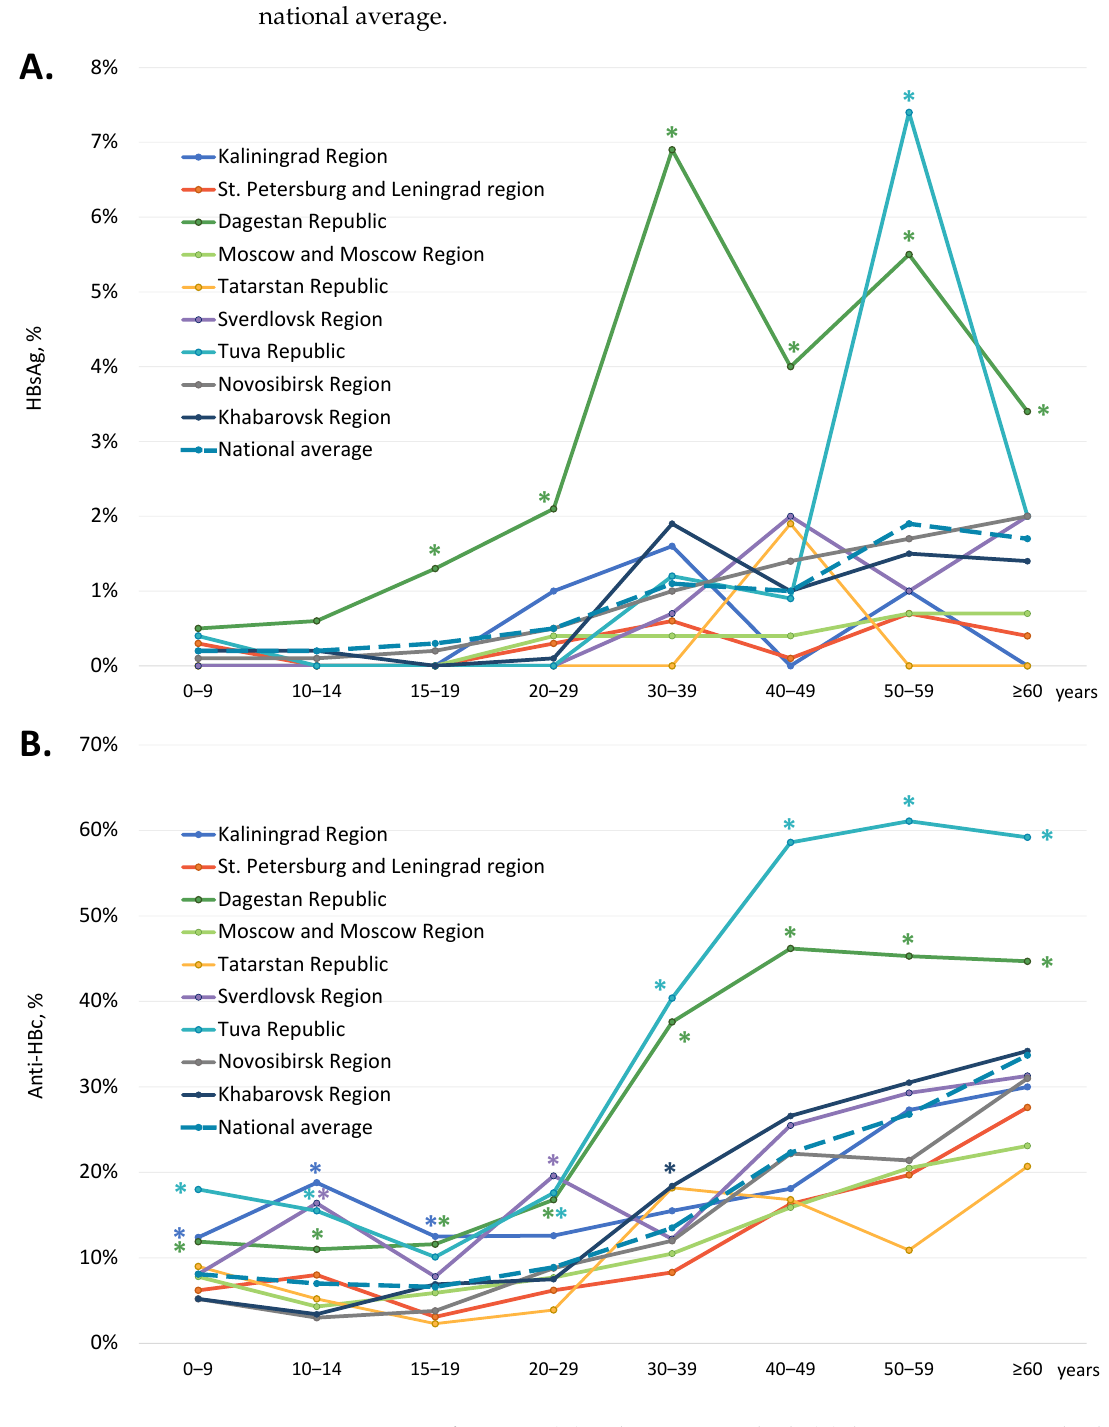
Figure 2. Age-specific HBsAg ( A ) and anti-HBc antibody ( B ) detection rates among healthy volunteers in the study regions. Values that are significantly higher than the national average values (two-tailed p < 0.05, Chi-square with Yates’ correction) are marked with an asterisk